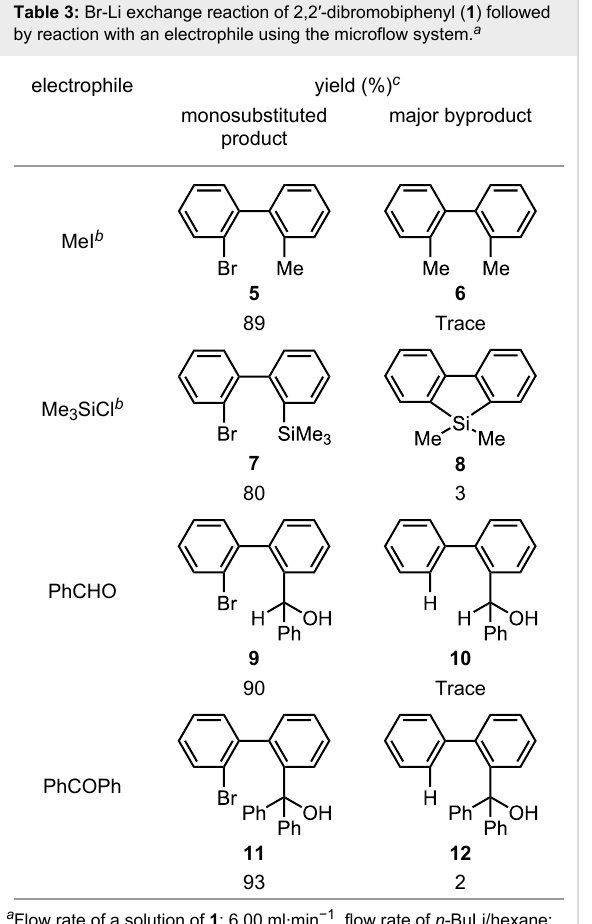
Table 3: Br-Li exchange reaction of 2,2′-dibromobiphenyl ( 1 ) followed by reaction with an electrophile using the microflow system. a